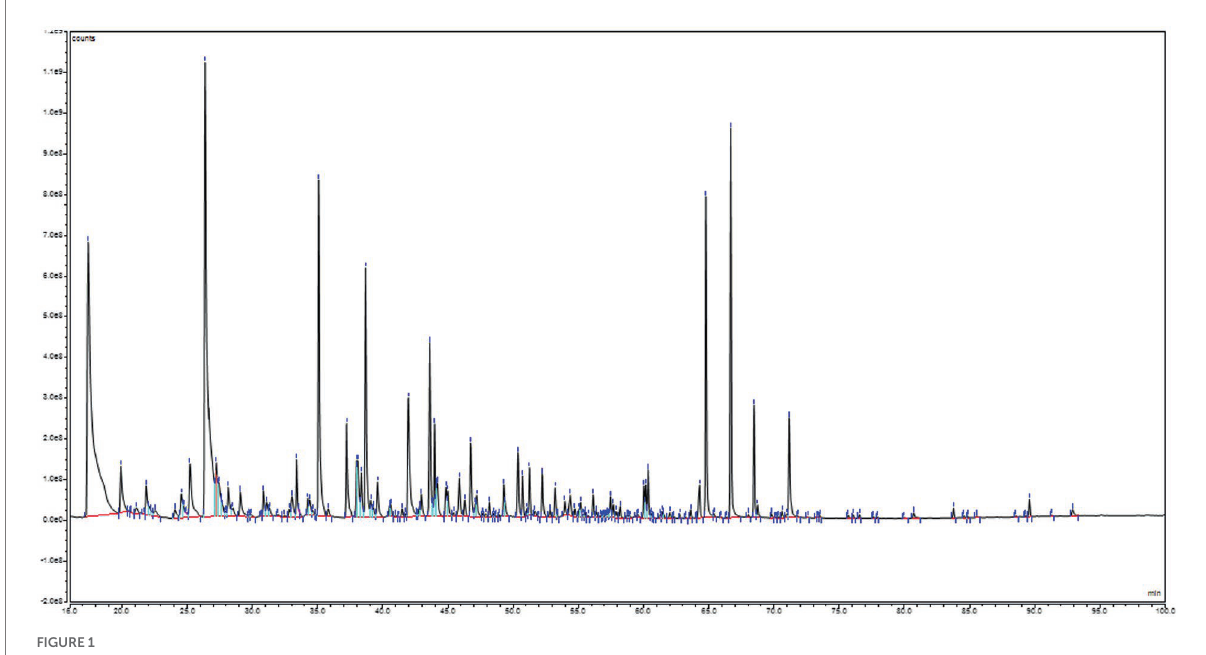
FIGURE 1 Typical GC–MS chromatogram of analyzed